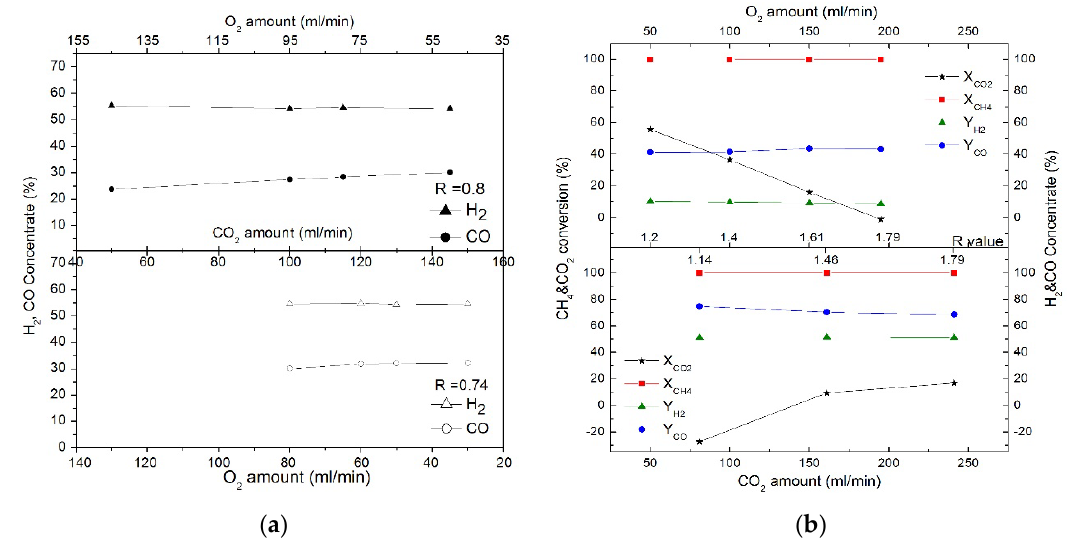
Figure 2. ( a ) Effect of CO 2 and O 2 as oxidant on H 2 and CO yields during biogas reforming at R = 0.74 and 0.8; ( b ) Effect of CO 2 and O 2 as oxidant on CH 4 and CO 2 conversion and H 2 and CO yields during biogas reforming when R > 1.